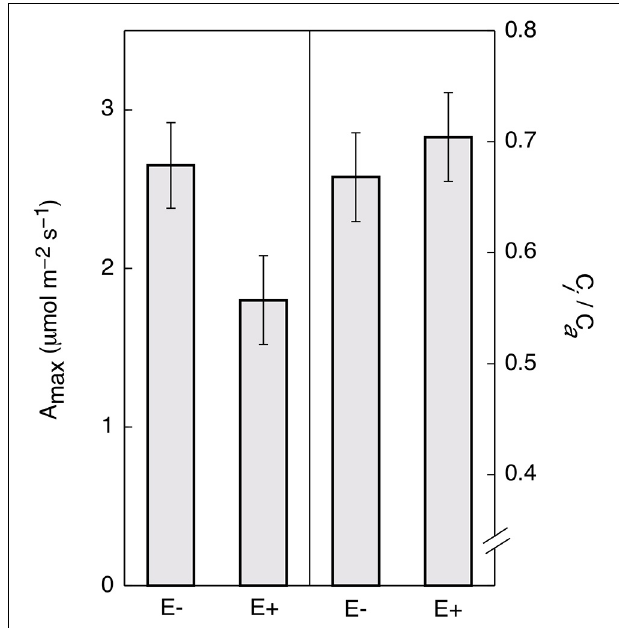
FIGURE 4 | Endophyte inoculation reduces maximum rates of photosynthesis (Amax) in T. cacao leaves. Maximum photosynthesis